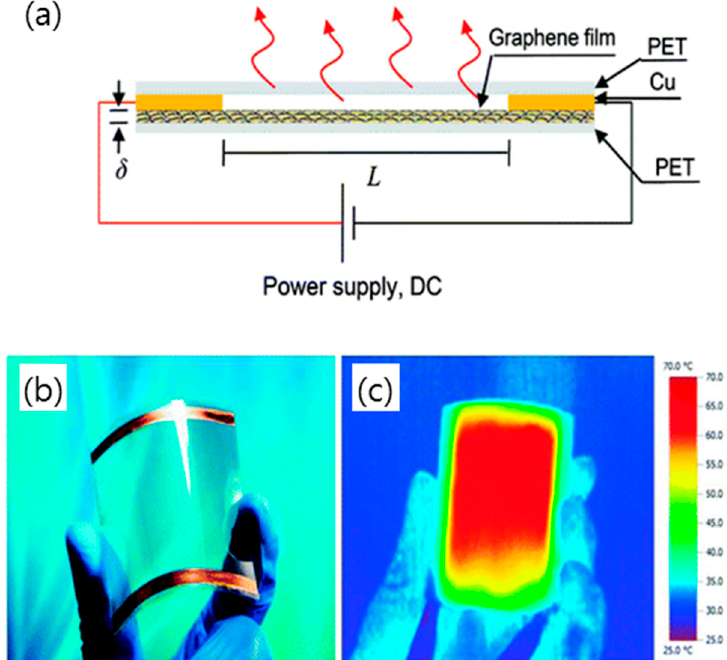
Figure 15. ( a ) A schematic structure of a transparent, flexible graphene heater combined with a plastic substrate and Cu electrodes. ( b ) An optical image of the assembled graphene-based heater showing its outstanding flexibility. ( c ) An infrared picture of the assembled graphene-based heater while applying an input voltage under bending condition. Reproduced with the permission of Reference [143]. Copyright 2011, American Chemical Society.